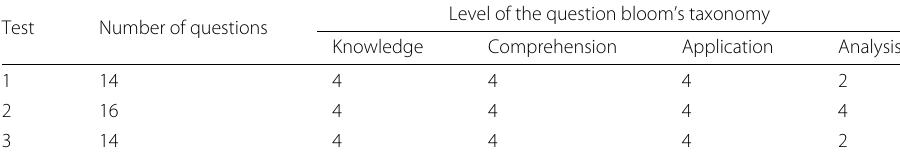
Table 6 Distribution of questions based on the level of the questions in Bloom’s taxonomy Test